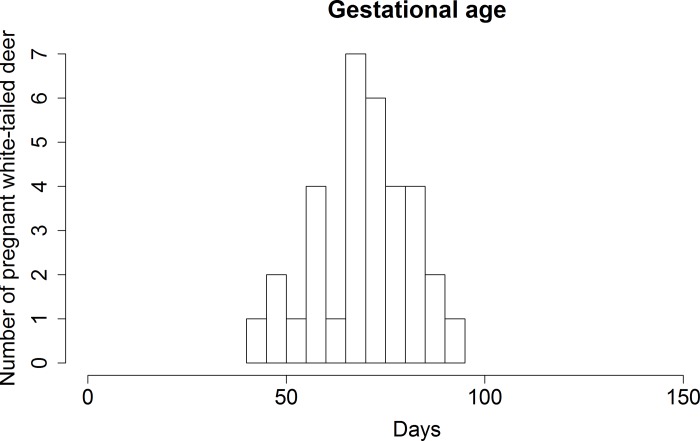
Gestational age of pregnant white-tailed deer.Pregnant white-tailed deer were all in the second trimesters of gestation.